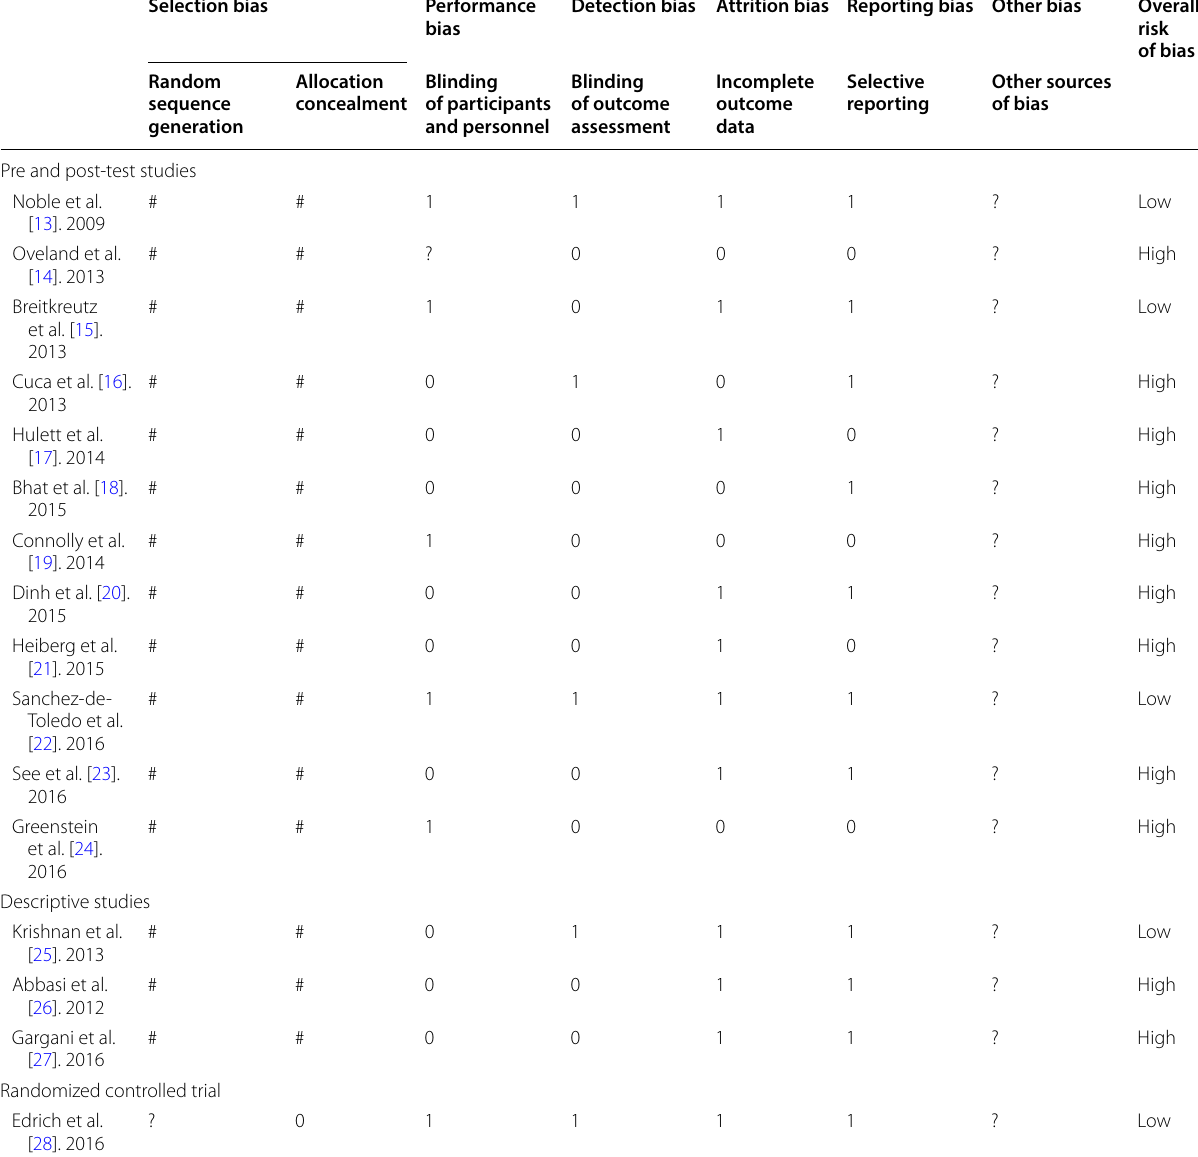
Table 3 Scores of the Cochrane Collaboration risk of bias assessment tool